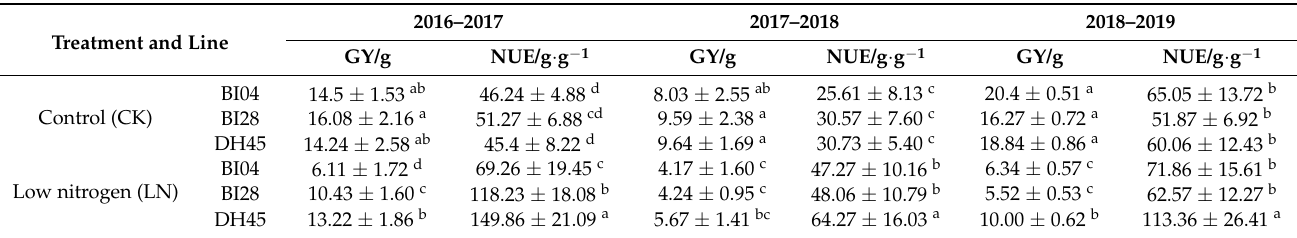
Figure 2. Comparison of relative grain yields between parents and DH lines from the year of 2016 to 2019. ( a ). The 1st screening of 85 DH lines in 2016–2017; ( b ). The 2nd screening of 10 DH lines in 2017–2018; ( c ). The 3rd screening of 10 DH lines in 2018–2019. The green and yellow columns represent the values of BI04 and BI28, respectively. The red lines indicate the value for a better parental line, and the maximum value for a “better” parent was also presented. The arrows indicate the performance of DH45. The relative grain yields were calculated as grain yield (g) under the low nitrogen (LN) condition/grain yield (g) under the control condition (CK). All data represent four biological replicates. Table 2. Comparison of grain yield and NUE between DH45 and parents at maturity stage (Zadoks growth scale 91) in field experiments (2016–2019).